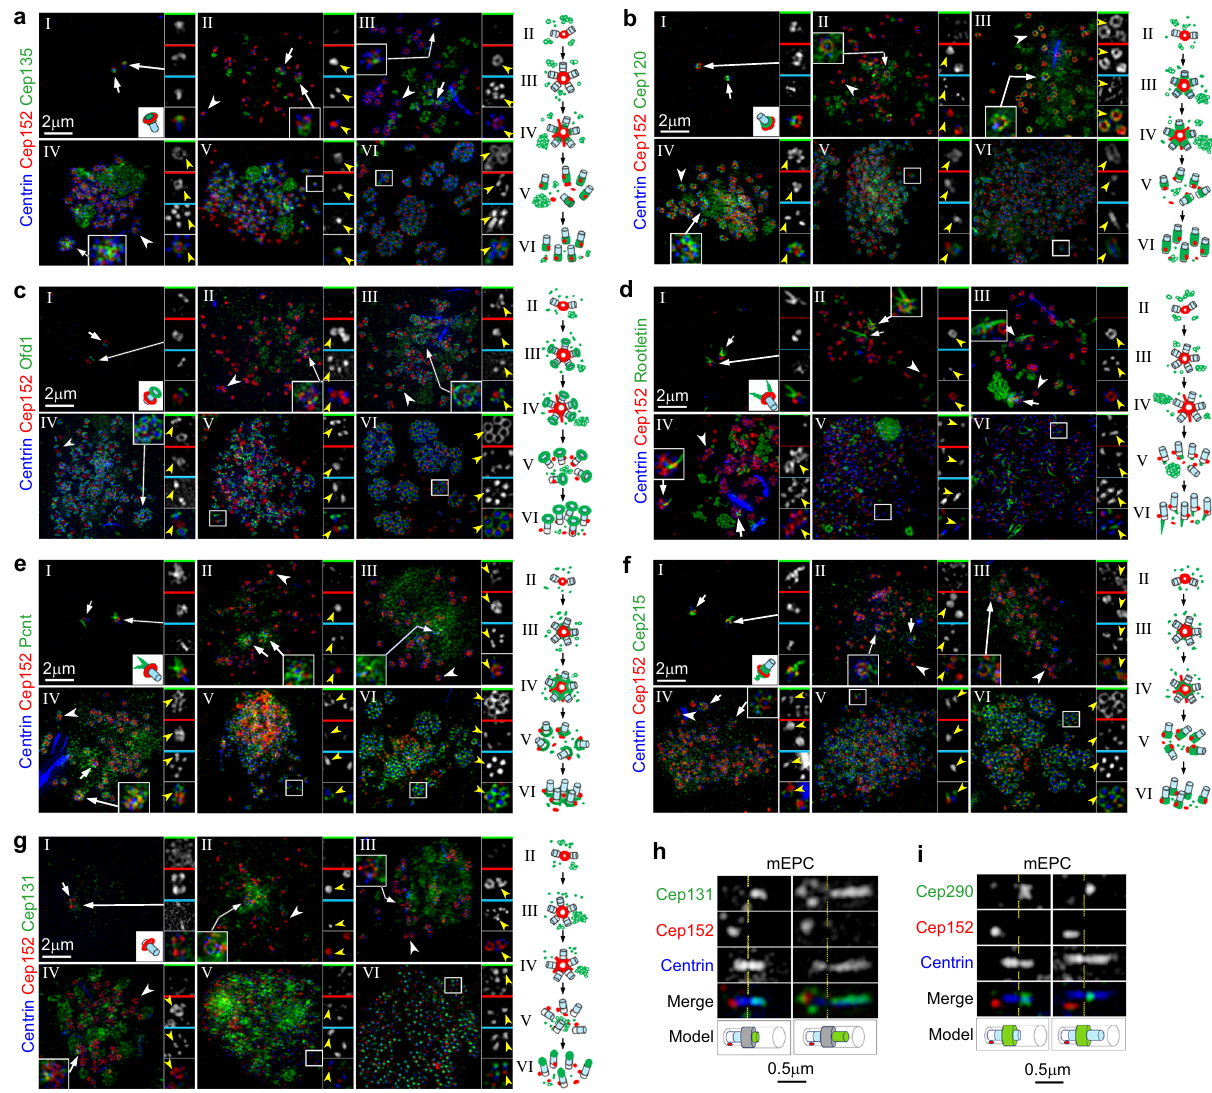
Fig. 5 Newly identi fi ed FGM proteins localize to nascent centrioles and cilia in diverse centriole ampli fi cation stages. a – g Representative 3D-SIM images for the indicated FGM proteins (green) in mTECs fi xed at day 3. White arrows indicate parental centrioles, one of which was magni fi ed. White arrowheads and frames respectively indicate typical regions containing deuterosomes and basal bodies that were magni fi ed to show details. Yellow arrowheads in the color-coded insets point to immuno fl uorescent signals related to typical nascent centrioles. The diagrams illustrate FGM protein localizations in stage-I parental centrioles and during the deuterosome-mediated centriole biogenesis (II – VI). h , i Cep131 localized to a novel Centrin-positive structure protruded from the center of transition zone into cilia. Shown are typical basal bodies in stage-VI mEPCs at day 3. Cep152 labeled the centriolar proximal side. Cep290 served as transition zone marker. The constrictions of Centrin streaks are marked by dashed lines. Note that Cep131 localized to the region of Centrin streaks above the constriction and sometimes also displayed additional punctate immuno fl uorescent signals around the basal bodies ( h